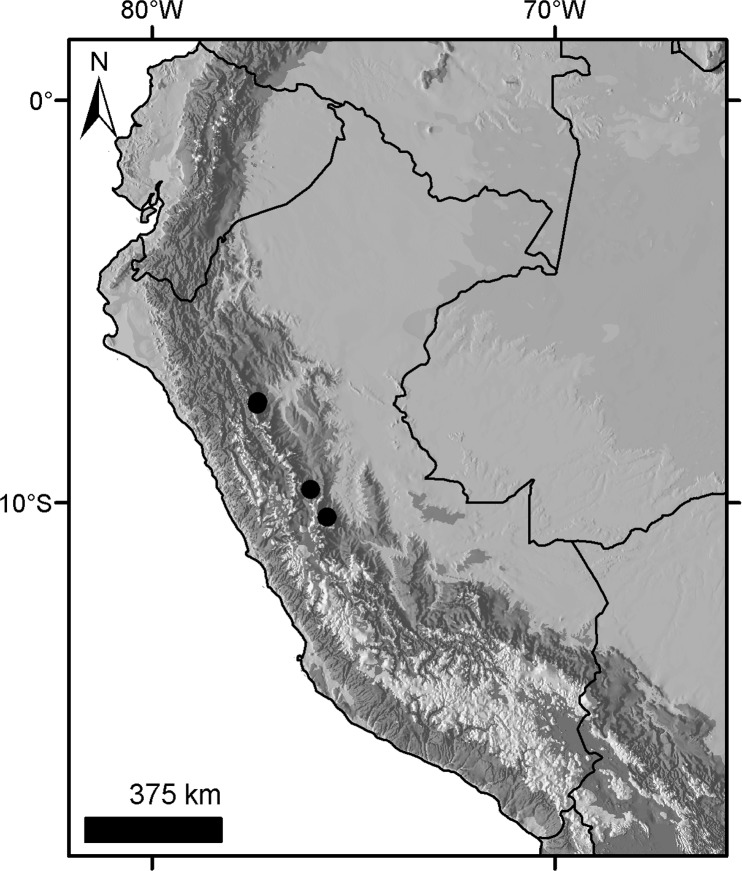
Localities recorded for Dasypus pilosus, all restricted to the Peruvian Andes.